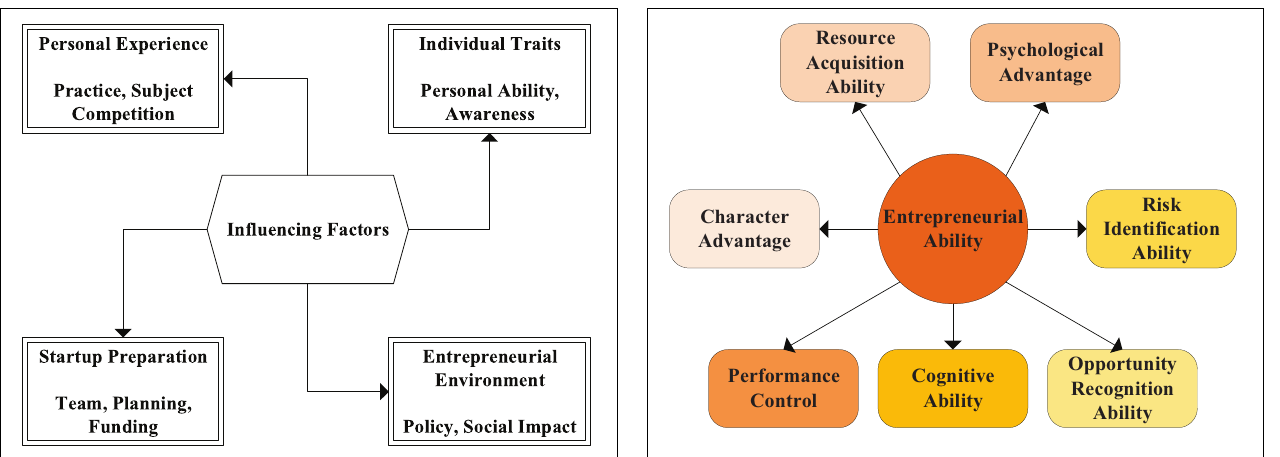
FIGURE 5 | Variable indicators of entrepreneurial